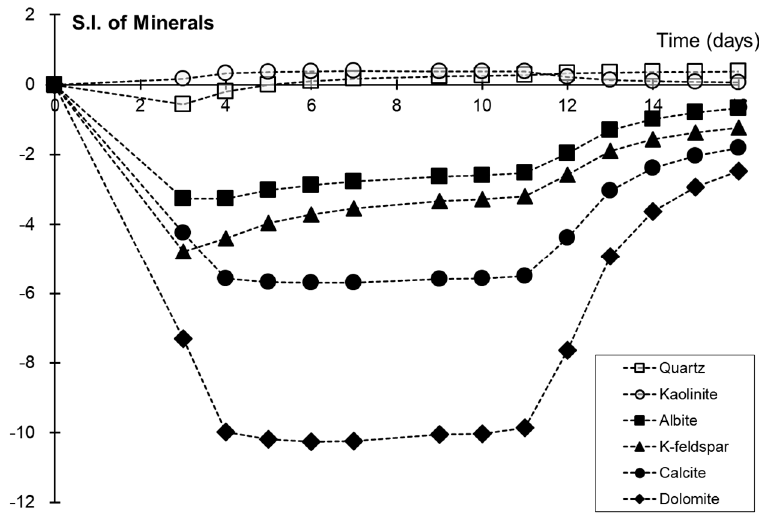
Figure 8. Saturation indices of carbonate minerals vs. reaction time in the numerical